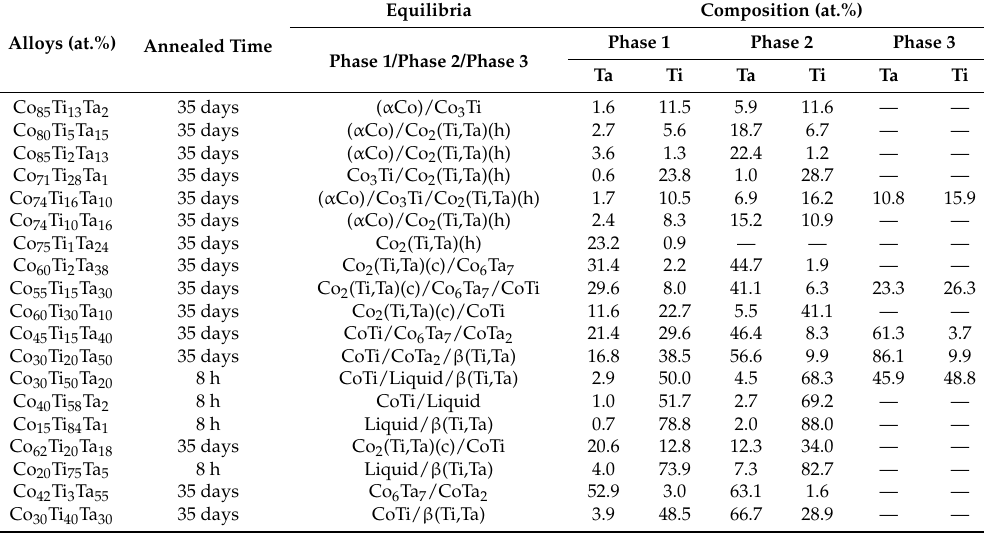
Table 3. Equilibrium composition of the Co-Ti-Ta ternary system at 1100 ◦ C determined in the present work.